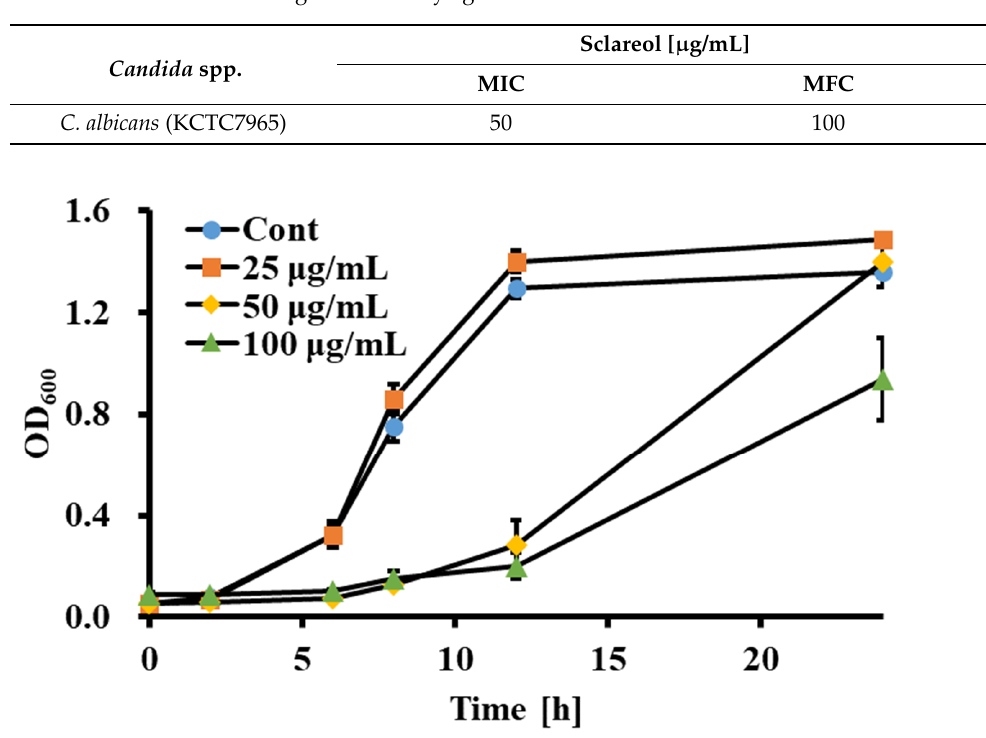
Figure 2. The growth of C. albicans was inhibited by treatment with sclareol. C. albicans (OD 600 = 0.05) cells were cultured with 25–100 μg/mL of sclareol for 24 h at 30 °C. The growth was monitored by change in absorbance at 600. Data are presented as mean ± SD from three independent